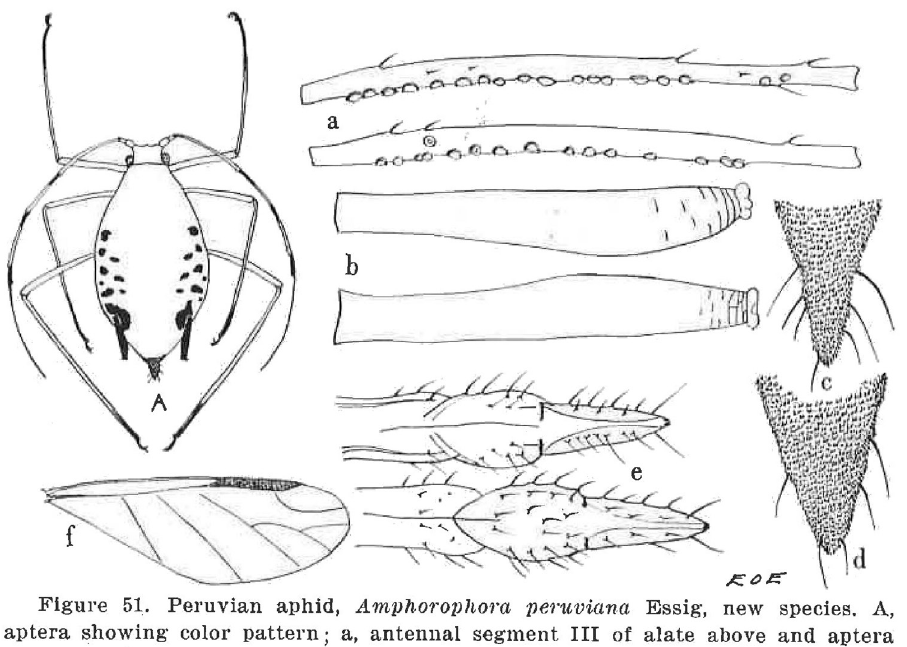
Figure 1. Illustration by Essig (“E O E”), with its legend, of the description of Amphorophora peruviana , on page 133 of his article (Essig, 1953). (Note: contrary to the legend, the antennal segment III attributed to an apterous viviparous female must be from an alate female, as Essig described the aptera (on page 135) as being without secondary